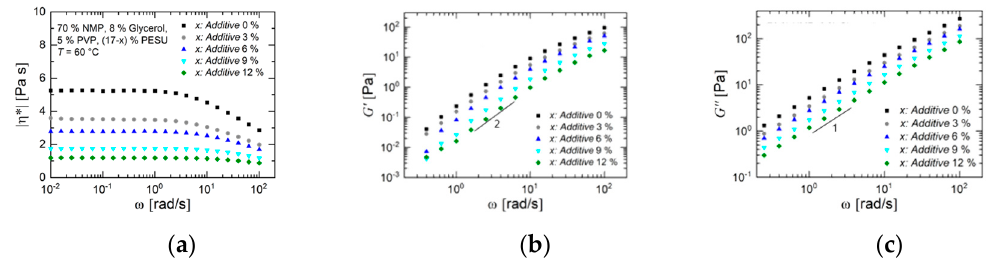
Figure 5. ( a ) Magnitude of complex viscosity as a function of angular frequency ω for solutions with additive concentrations of 0–12 %. ( b ) Storage modulus G' as a function of angular frequency ω for these solutions. The data points at frequencies smaller than 0.3 rad/s are below the measurement resolution and thus are not shown. ( c ) Loss modulus G'' as a function of angular frequency. The temperature was 60 °C.